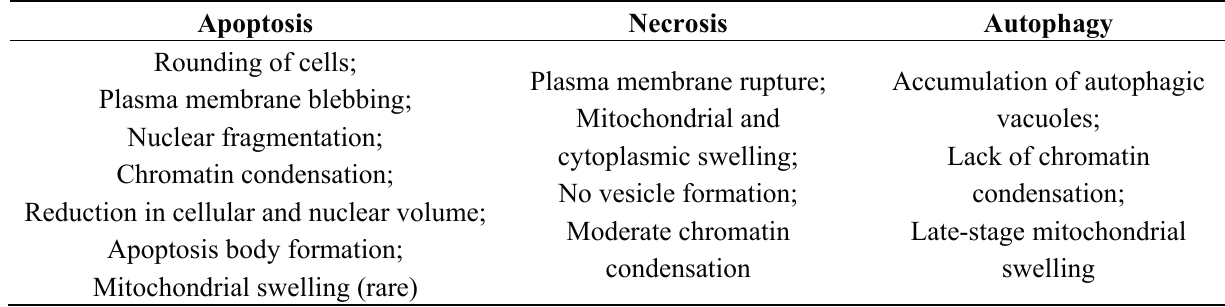
Figure 3. Key features of autophagy. Cytoplasmic and intracellular organelles are sequestered within autophagic vacuoles to be degraded by lysosomes. Table 1. Key features of different types of cell